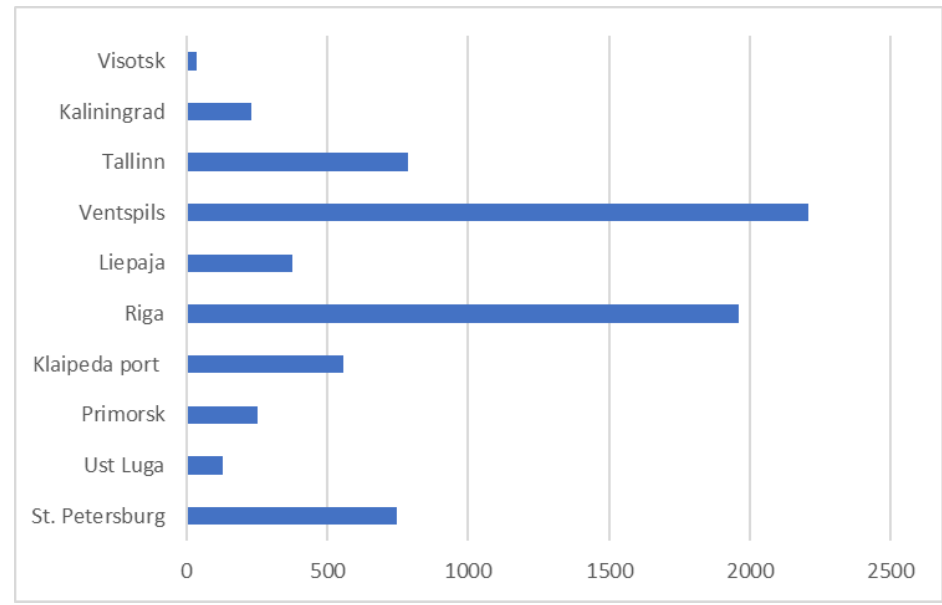
Logistics 2022 , 6 , x FOR PEER REVIEW Figure 13. Comparison of the Port area (hectares). Figure 13. Comparison of the Port area (hectares).